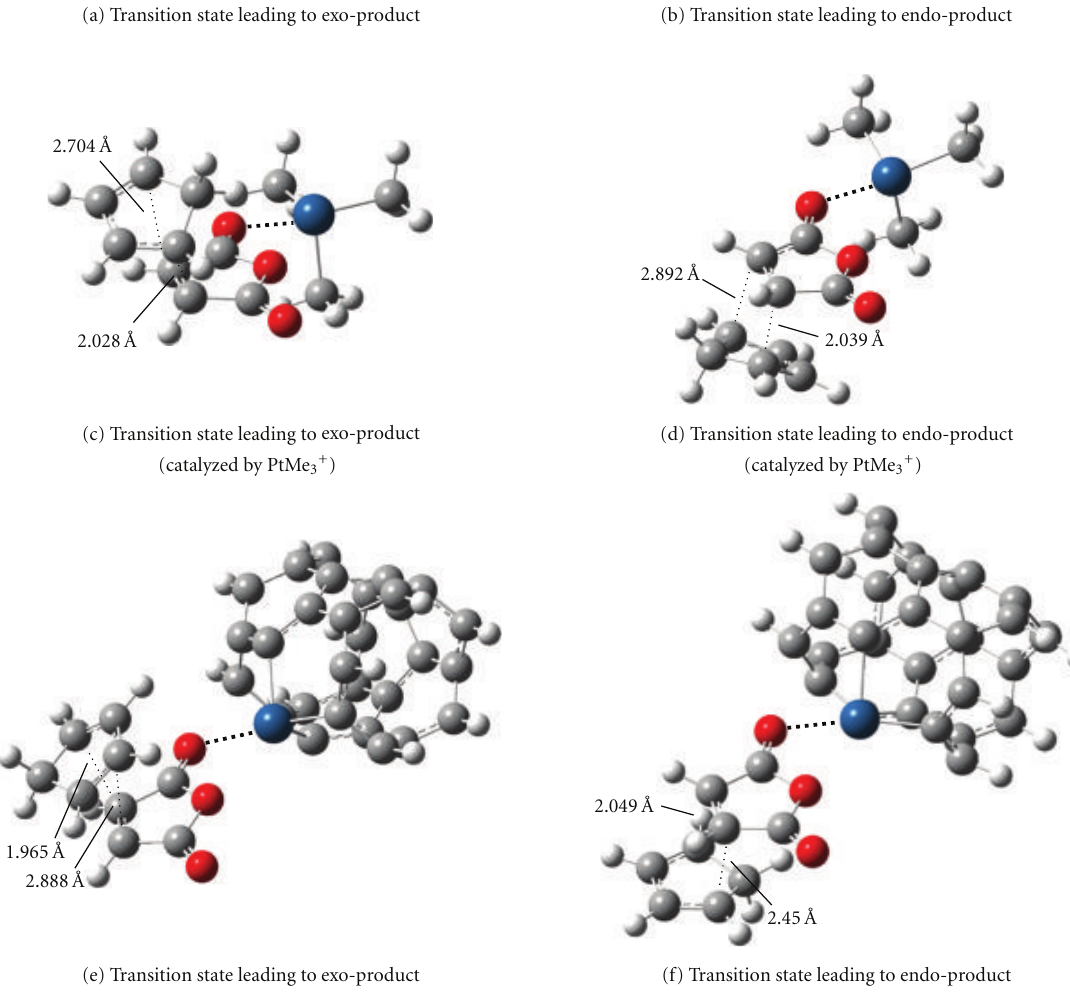
Figure 31: Transition states of the Diels-Alder reaction of maleic anhydride and cyclopentadiene as catalyzed by alkyl- and arylplatinum complexes [45]. Legend: dark grey = carbon, light grey = hydrogen, red = oxygen, blue =